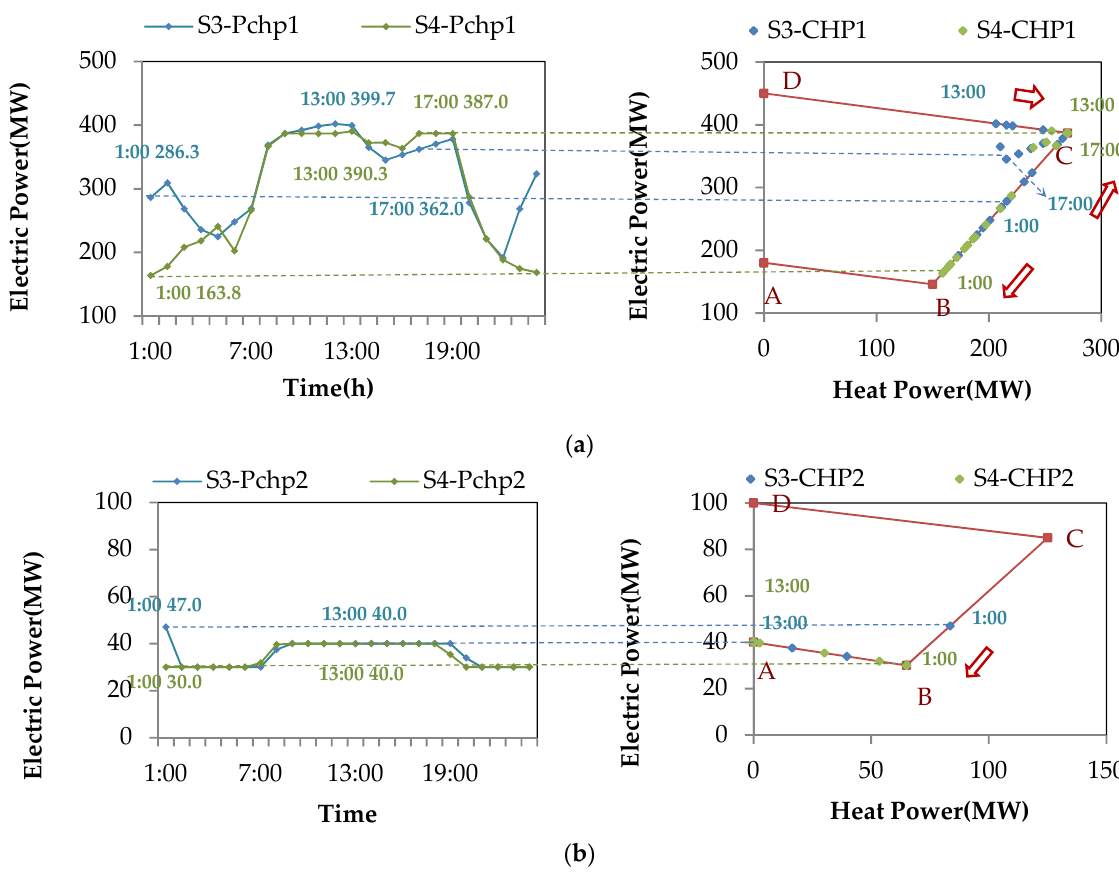
Figure 7. Operation state of CHP units: ( a ) CHP1 and ( b ) CHP2. With a comparison of the operation status of the CHP units, we can see the